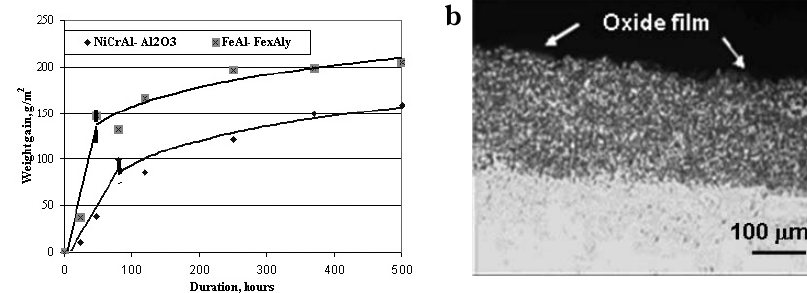
Fig.5 Comparative oxidation behavior of HVOF coatings (a) and cross-section of HVOF coating from FeAl-Fe x Al y powder after 48 hour duration in air at 950 ℃ (b) 97 .